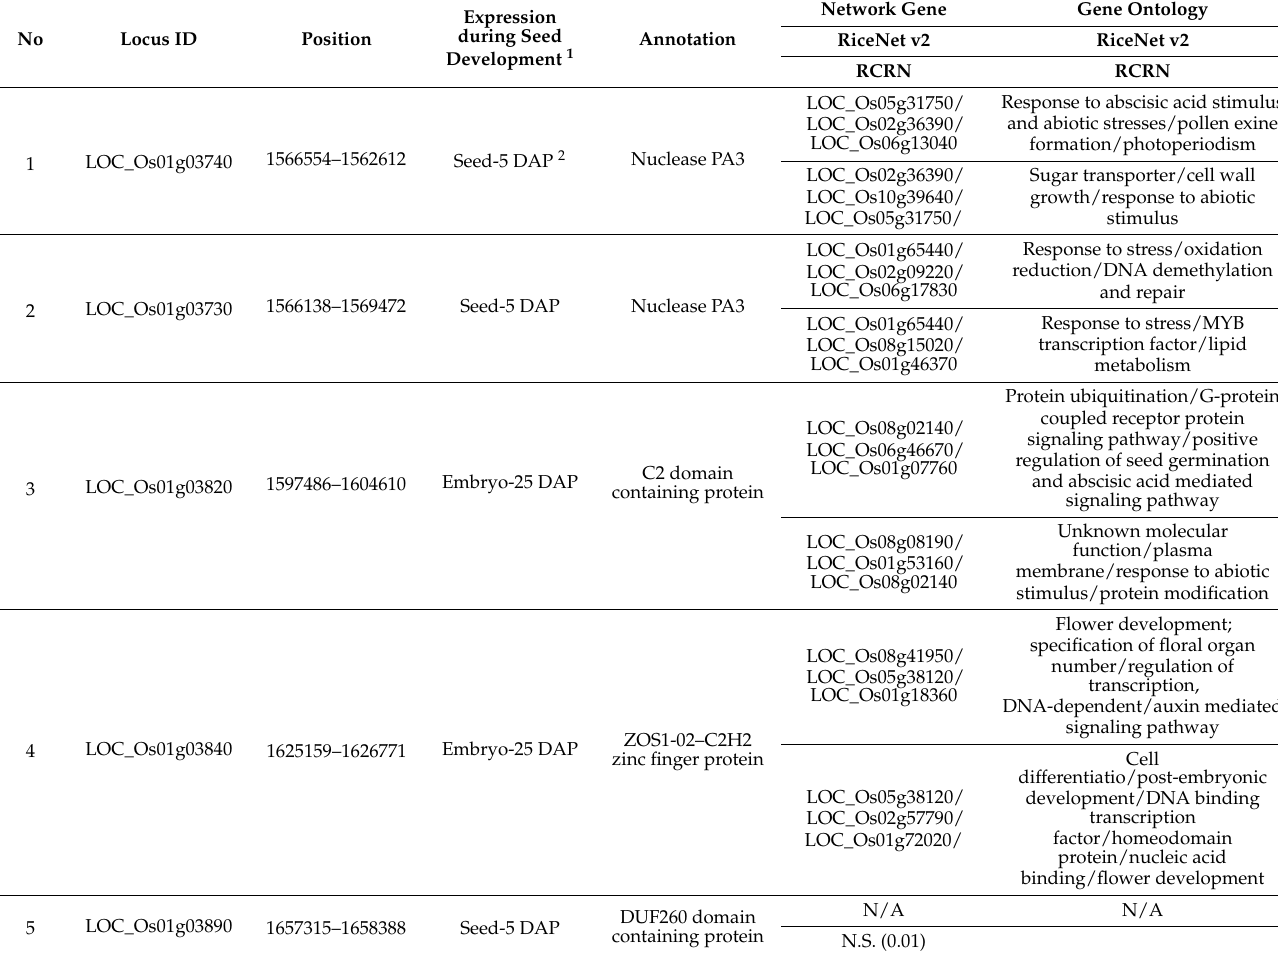
Table 1. List of a priori candidate genes enhancing pre-harvest sprouting tolerance in japonica rice. For the RCRN, a not significant (N.S.) value is the maximum edge